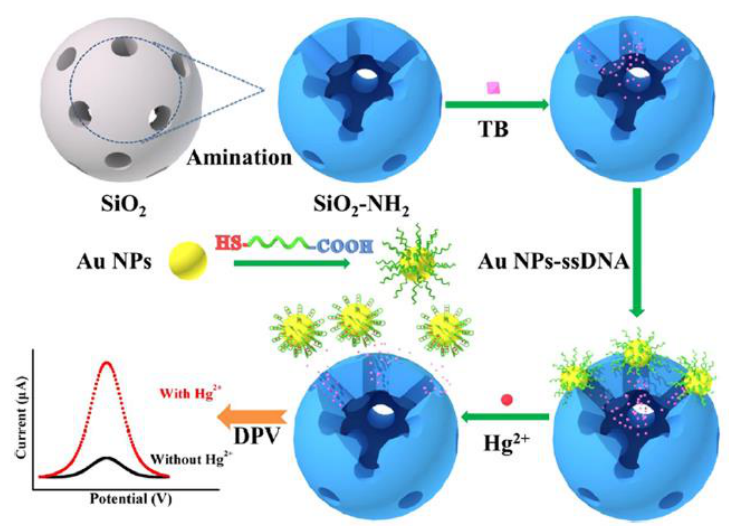
Figure 7. Schematic representation of the amperometric sensor for mercury ion based on analyte-controlled release of redox marker. Adapted with permission from Ma et al. [60] (Copyright © (2020) ACS.